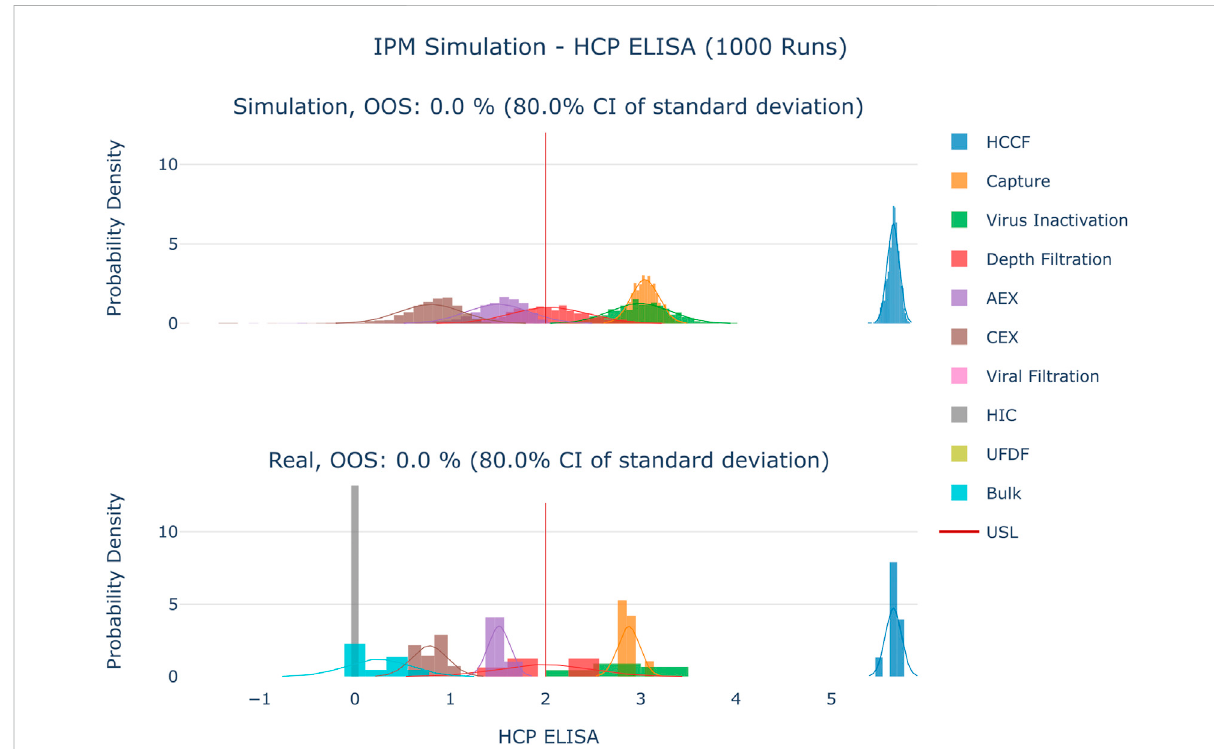
FIGURE 4 Comparisonofdistributions ofthesimulationto10largescalemanufacturingrunsfortheCQAHCPELISA.Theupperplotshowsthesimulated data based on 1000 simulations performed at set-point conditions. The lower plot shows the data from 9 large scale runs. Due to the large value range of this CQA the values were logarithmically scaled for visualization